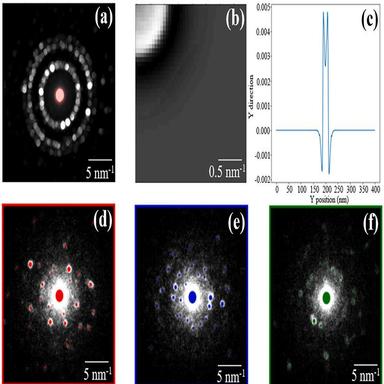
Bragg disk detection in the SiOC ceramic: (a) averaged diffraction pattern of 4D-STEM datacube (red shield – bright-field detector), (b) the vacuum probe template, (c) a kernel for cross correlation template matching with individual diffraction patterns, and (d-f) the detected Bragg disk positions. (For interpretation of the references to colour in this figure legend, the reader is referred to the web version of this article.)